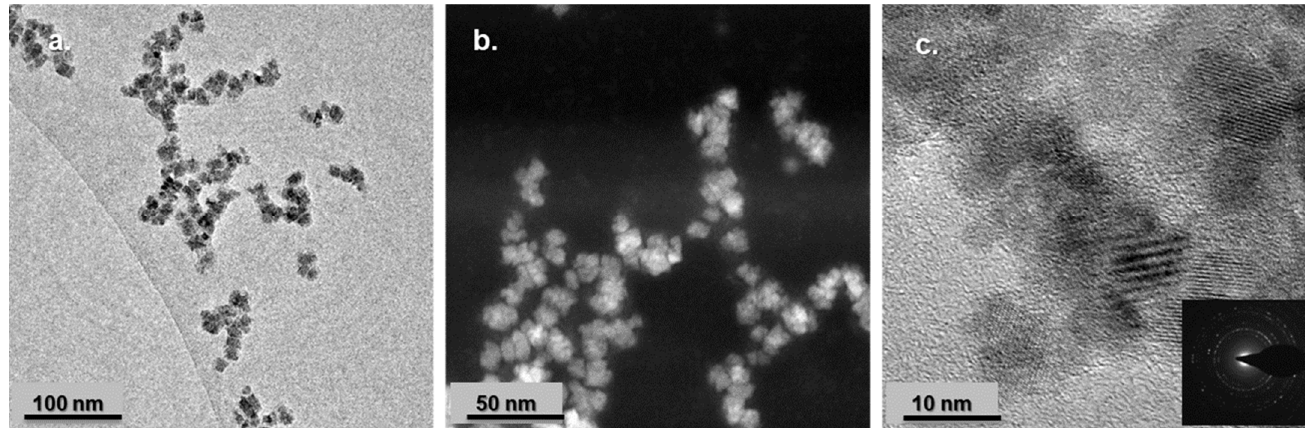
Figure 2. Transmission electron microscopy images of PP-MNPs ( a ) TEM phase-contrast image; ( b ) HAADF-STEM image; ( c ) HREM image and in the inset SAED polycrystalline pattern rings. Scale bars: ( a ) 100 nm; ( b ) 50 nm; ( c ) 10